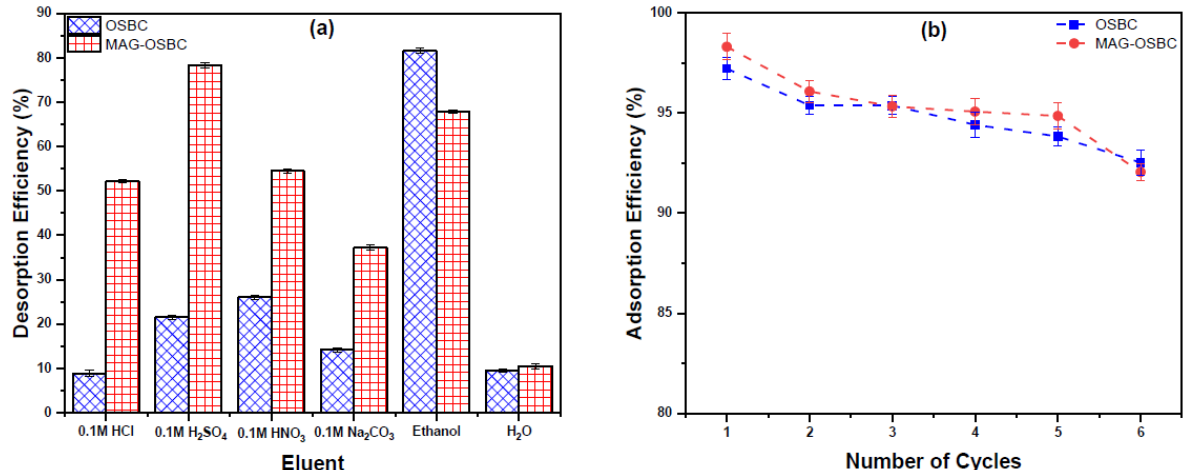
Figure 12. ( a ) Effect of eluent type on the CLOF desorption from OSBC, MAG–OSBC , and ( b ) the regeneration performance of both adsorbents for the CLOF